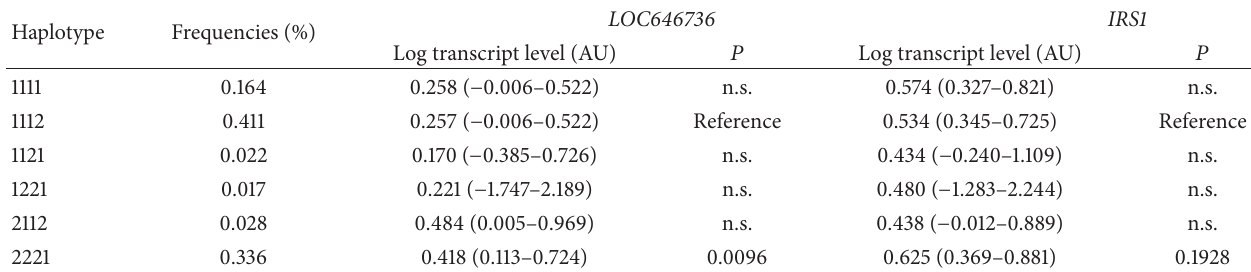
Table 4: Haplotypes and LOC646736 and IRS1 transcript levels in skeletal muscle.